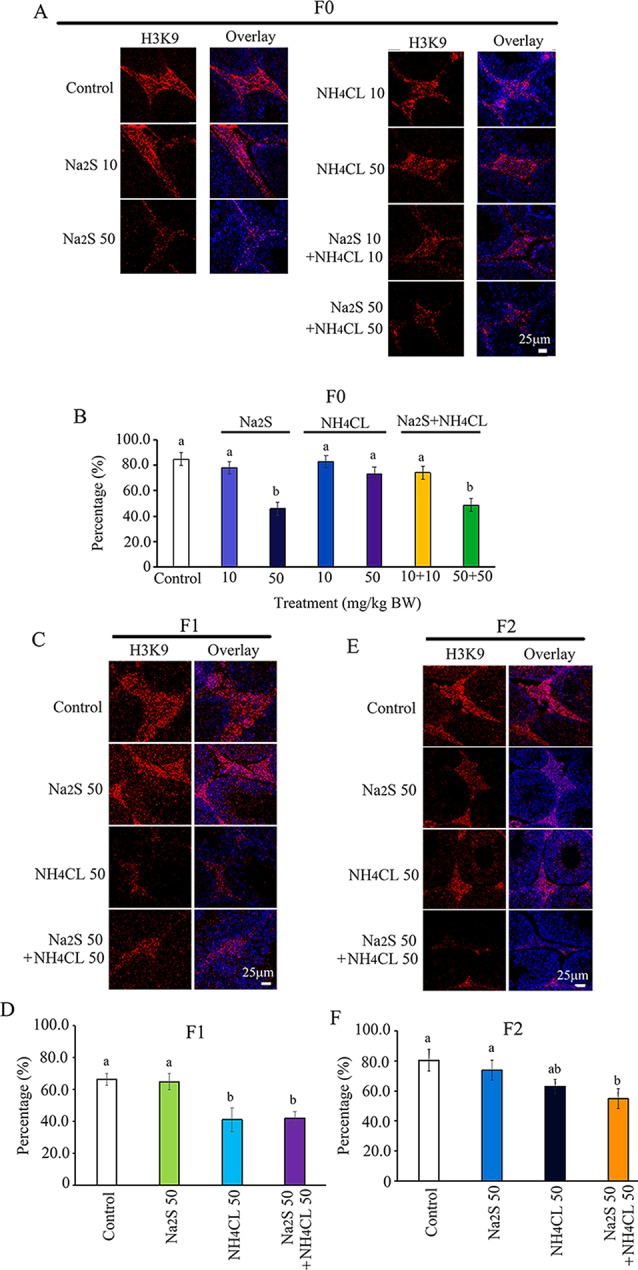
Protein H3K9 in mouse testicular tissue as detected by immunofluorescence staining. (A) H3K9 staining in F0 mouse testis. (B) Quantitative data for H3K9 in F0 mouse testis. (C) H3K9 staining in F1 mouse testis. (D) Quantitative data for H3K9 in F1 mouse testis. (E) H3K9 staining in F2 mouse testis. (F) Quantitative data for H3K9 in F2 mouse testis. N > 6. a, b indicate a significant difference among different treatments (p < 0.05).